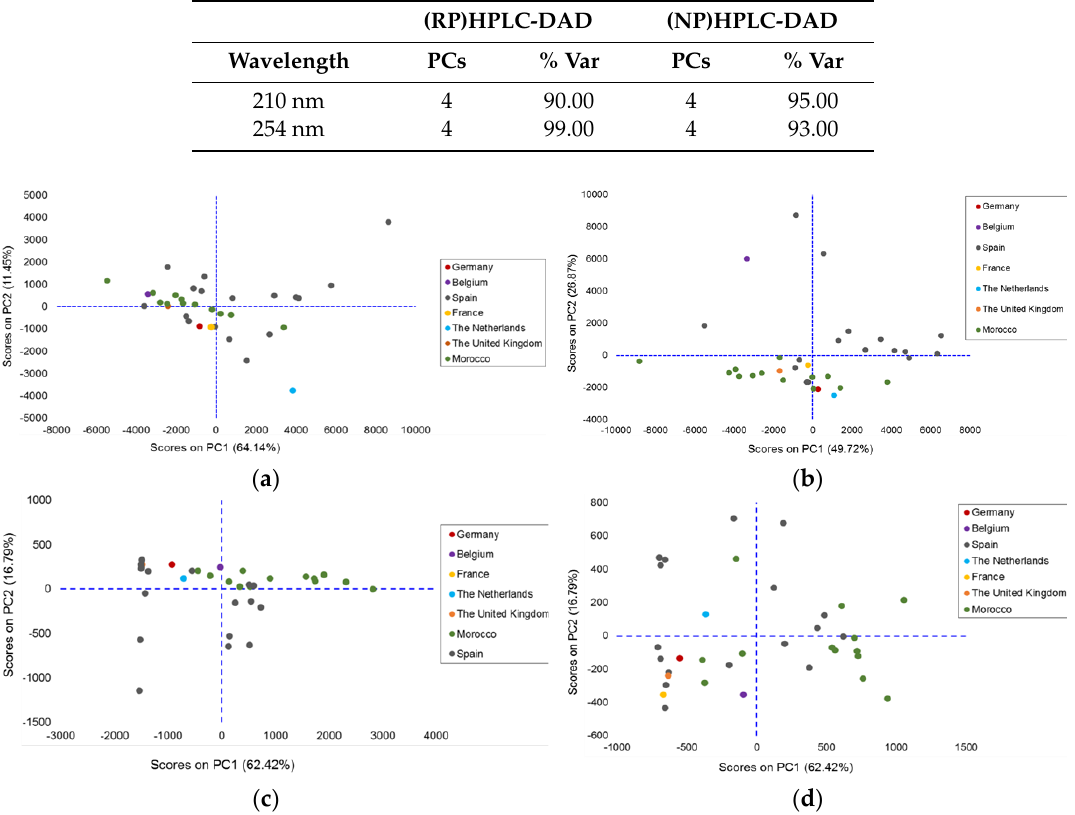
Figure 2. PCA scores obtained from the fingerprint data of the 35 margarine samples: PC1–PC2 plane of the chromatogram acquired at 210 nm: ( a ) In reverse phase; ( b ) In normal phase; and acquired at 254 nm: ( c ) In reverse phase; ( d ) In normal phase.